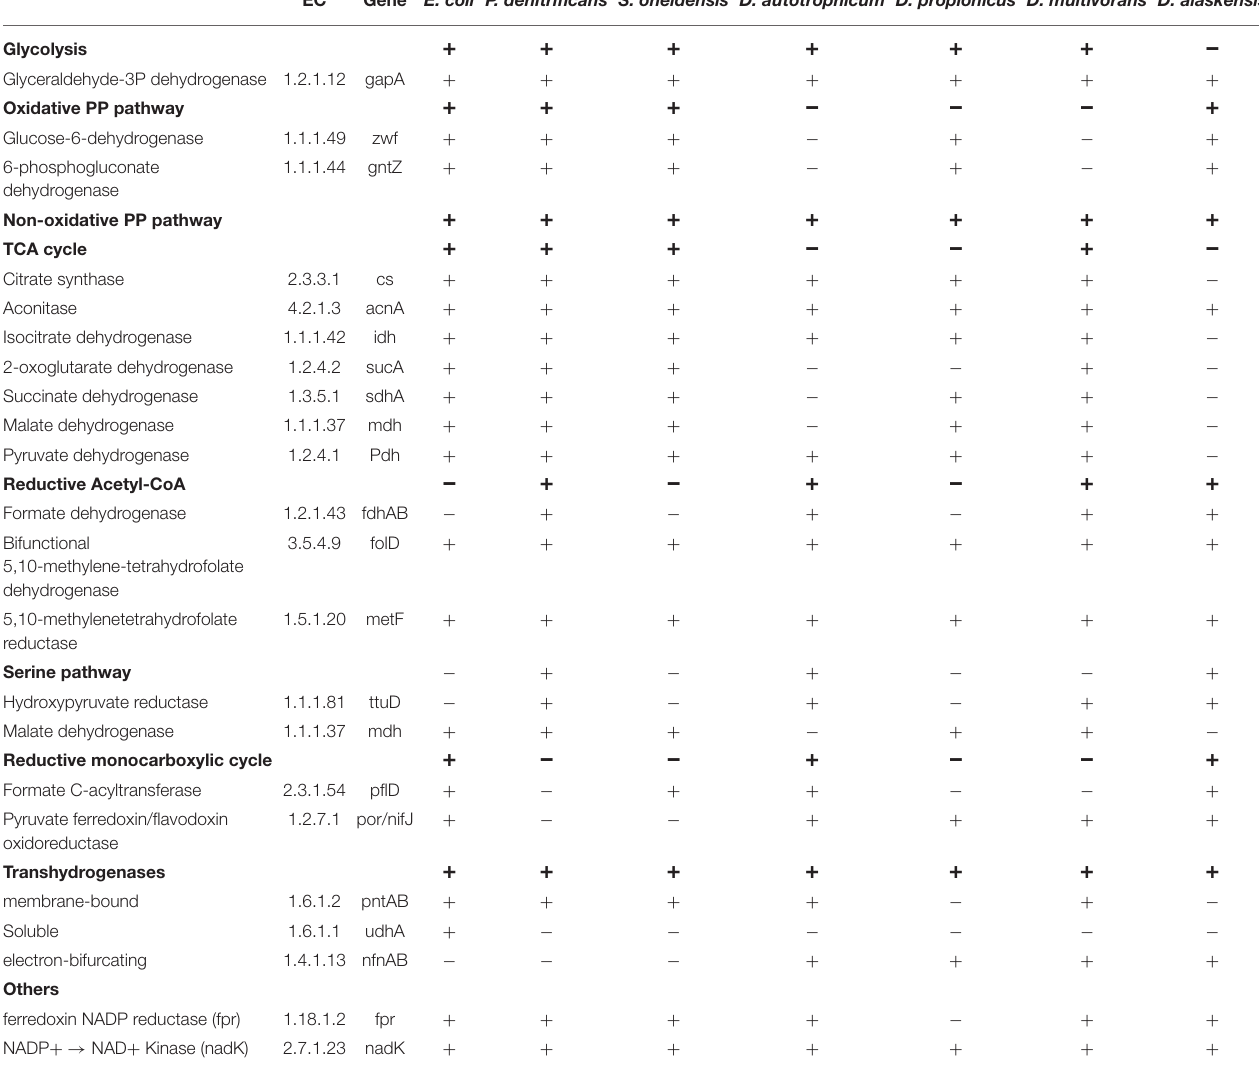
TABLE 2 | Metabolic pathways and selected gene content of